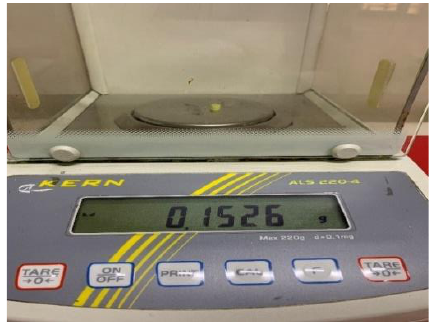
Figure (5) : digital electronic balance